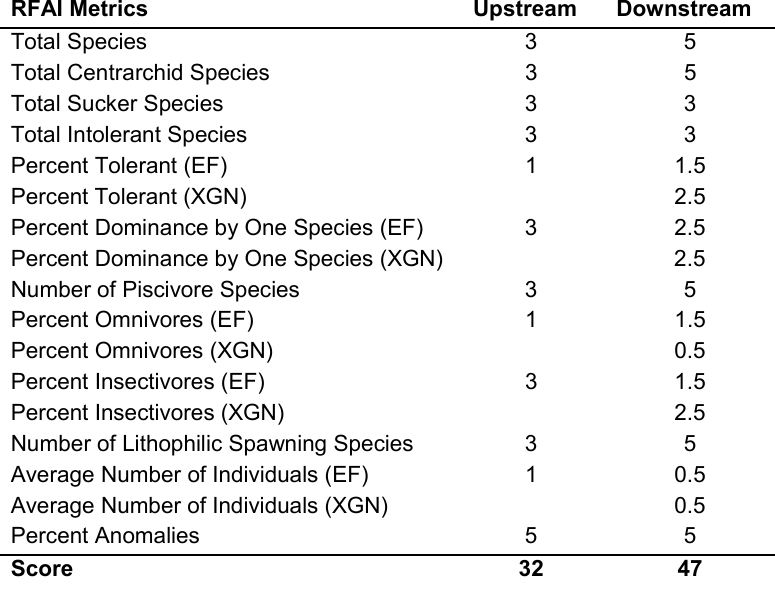
Individual RFAI Metric Results From Melton Hill Reservoir Samples in the Vicinity of Bull Run Steam Plant, Fall